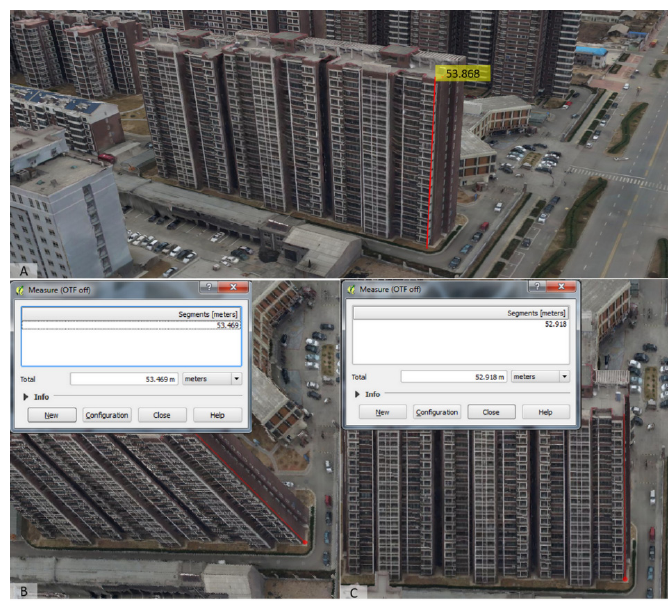
Figure 11. Measuring building height ( A ) in a real 3D environment; ( B ) on a 2.5D map with θ = 315 ◦ , ϕ = 45 ◦ ; ( C ) on a 2.5D map with θ = 0 ◦ , ϕ = 45 ◦ . Table 4. Comparison of the building heights measured on a 2.5D map and in a 3D GIS. Building